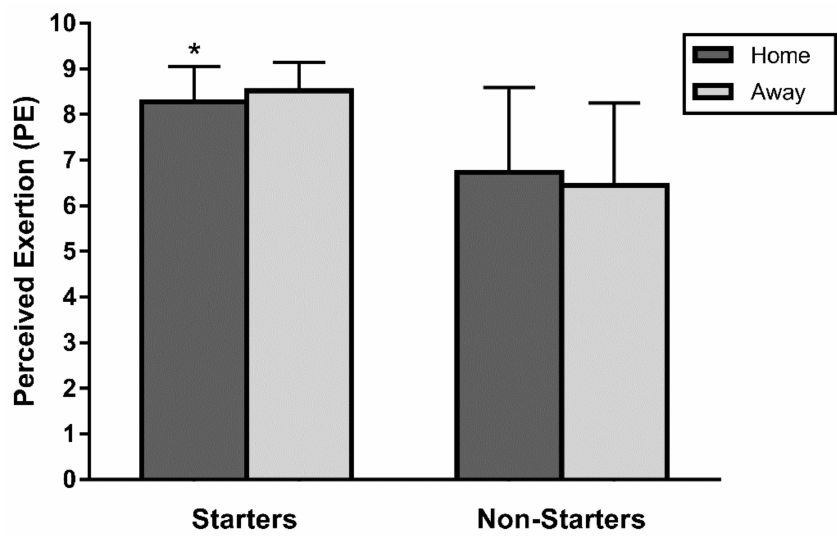
Figure 3. PE for starters and non-starters attending to playing at home or away. * Significant di ff erences between home and away matches ( p <